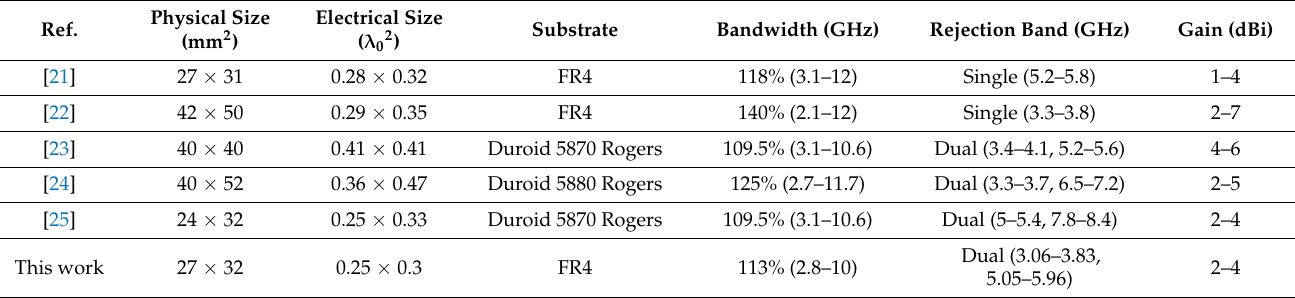
Table 2. Comparison of the proposed and reference